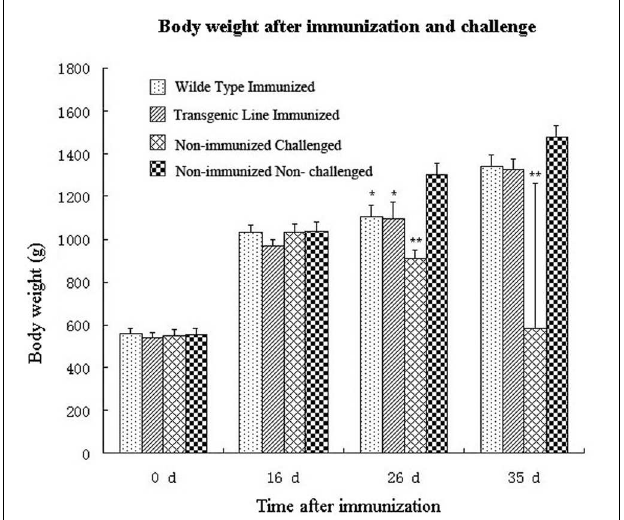
FIGURE 5 | Body weights of rabbits after immunization with 5 × 10 3 transgenic or wild-type E. intestinalis oocysts and challenged with 1 × 10 6 wild-type E. intestinalis oocysts at 16 days after immunization ( n = 4). ∗ p < 0.05, ∗∗ p < 0.01 (compared with the unimmunized and unchallenged